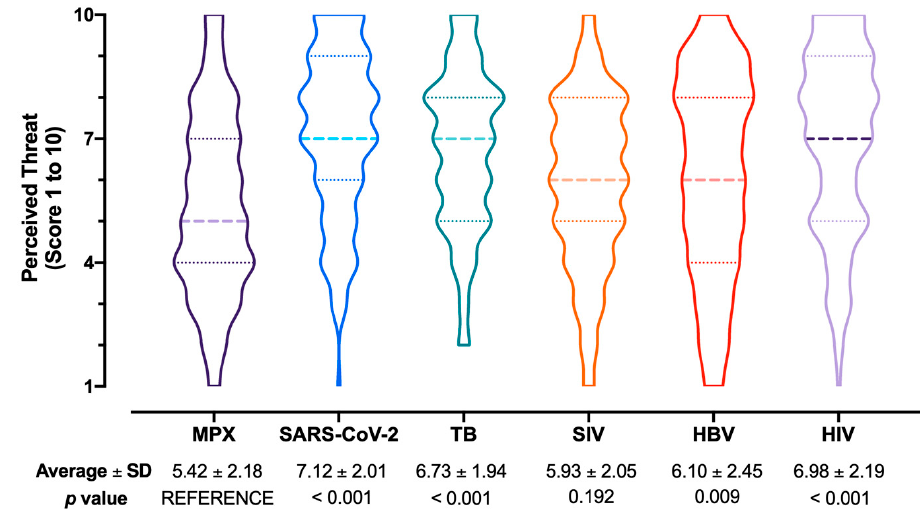
Figure 4. Box and violin plot for the perceived burden on National Health Service of Monkeypox (MPX) compared to SARS-CoV-2, Tuberculosis (TB), Seasonal Influenza Virus (SIV), Hepatitis B Virus (HBV), and Human Immunodeficiency Virus (HIV) infections. Comparisons were performed by mean of the Kruskal–Wallis test for multiple comparisons by assuming MPX as the reference group.